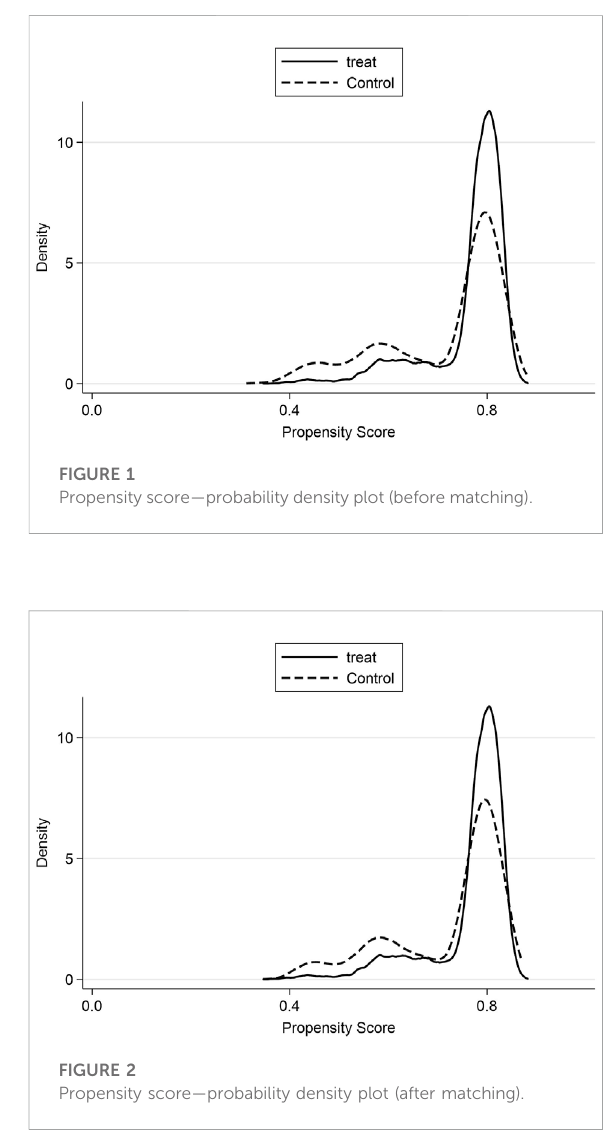
Table 7 show that the effect of natural disasters on the wealth of high- and low-consumption households is negatively signi fi cant. This indicates that natural disasters harm the wealth of both low- and high-consumption households. The